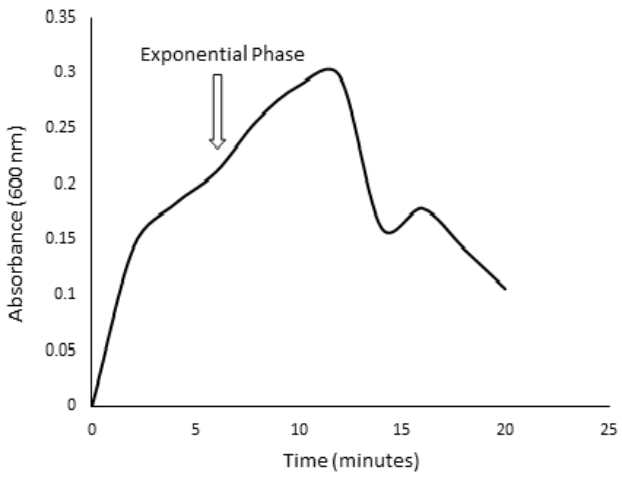
Figure 2. Growth Curve of a typical bacterial isolate from the experiment, showing the exponential phase, which was used to derive the data sets and growth rates.